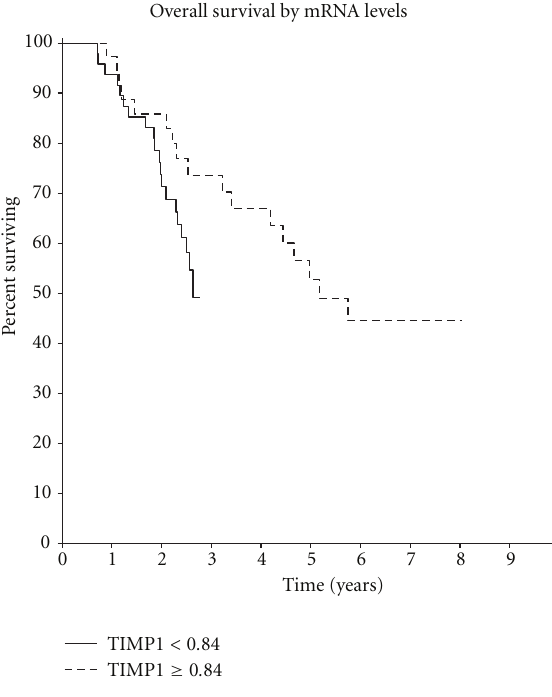
Figure 1: (HR = 1 . 64 P = 0 . 04). Table 3: Multivariate analysis for recurrence-free survival using TIMP-1 mRNA levels.